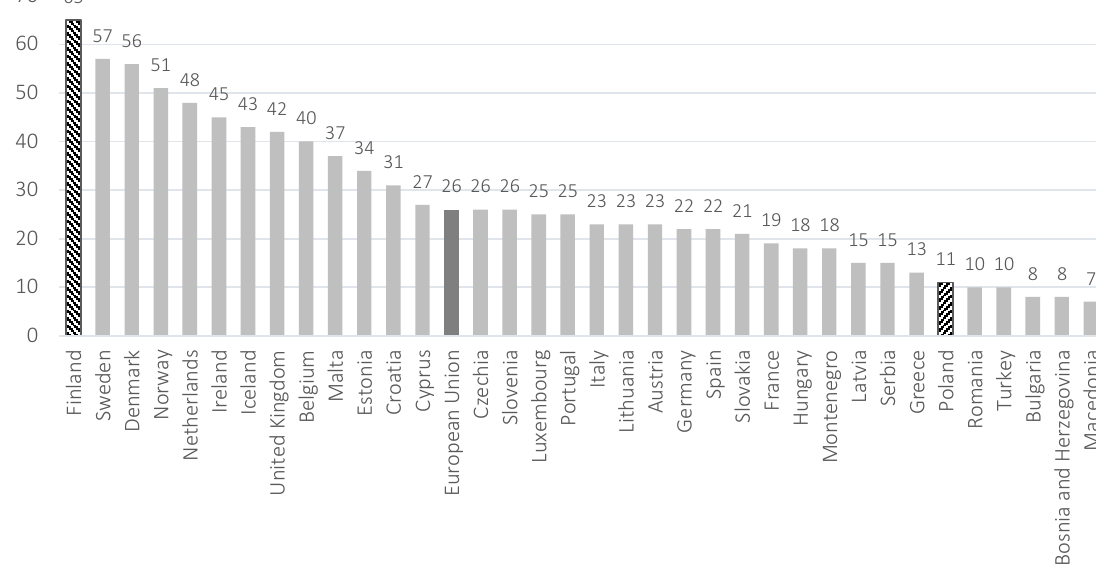
Figure 1. Percentage of companies in EU countries that bought cloud computing services in 2018